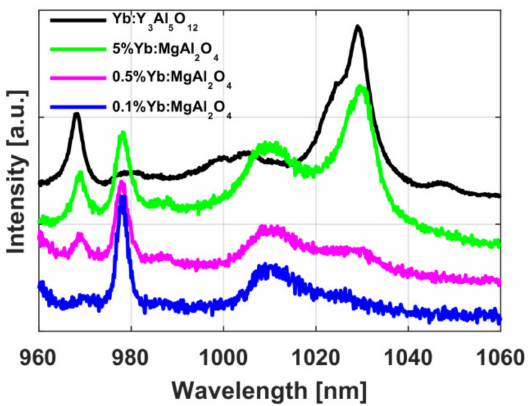
Figure 14. Luminescence spectra of MAS ceramics with the concentration of Yb 3+ ions 0.1% (blue), 0.5% (magenta), and 5% (green); black curve corresponds to the luminescence spectrum of Yb:YAG